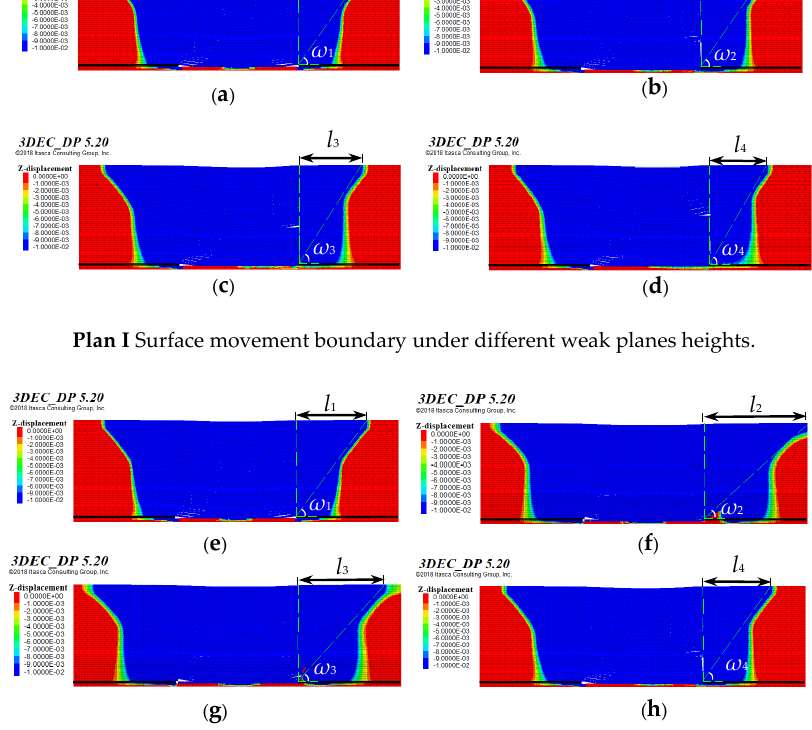
Figure 10. Surface movement boundary.